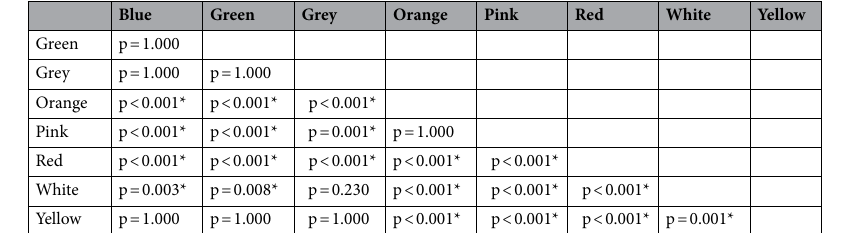
Blue Green Grey Orange Pink Red White Yellow Green